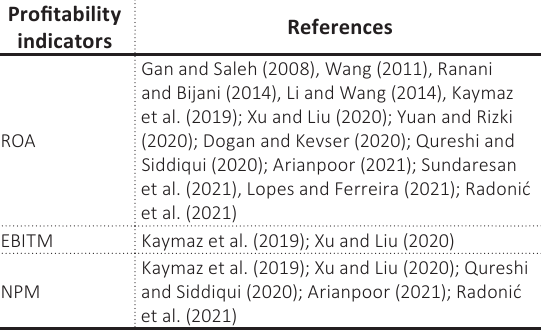
Table 1. Approaches to profitability